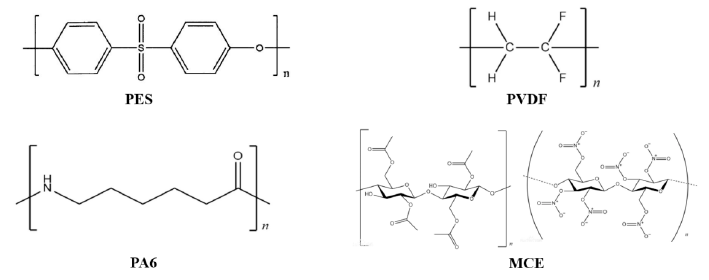
Figure 2. The molecular structures of PES, PVDF, PA6 and MCE.